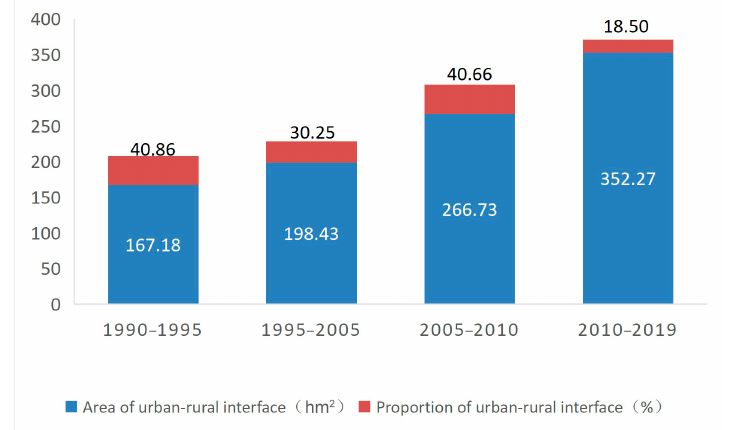
Figure 8. Characteristics of changes in the number of urban–rural interfaces in Zhulin, 1990–2019. During 1990–1995, all four types of spaces were transferred at the urban–rural interface, among which the largest transfer was agricultural production space. Only the transfer of agricultural production space to ecological space and ecological space to agricultural production space had a location entropy of land use transfer lower than one. The location entropy of all other transfers was greater than one. The highest was the transfer of non- agricultural production space to agricultural production space and living space, as well as the transfer of living space to non-agricultural production space, both at 2.45. During this period, except for the mutual transfer of ecological space and agricultural production space, the mutual transfer of all other land use types occurred mainly at the urban–rural interface (Table 8). Table 8. Spatial transfer of EPL spaces in the urban–rural interface area from 1990 to 1995.